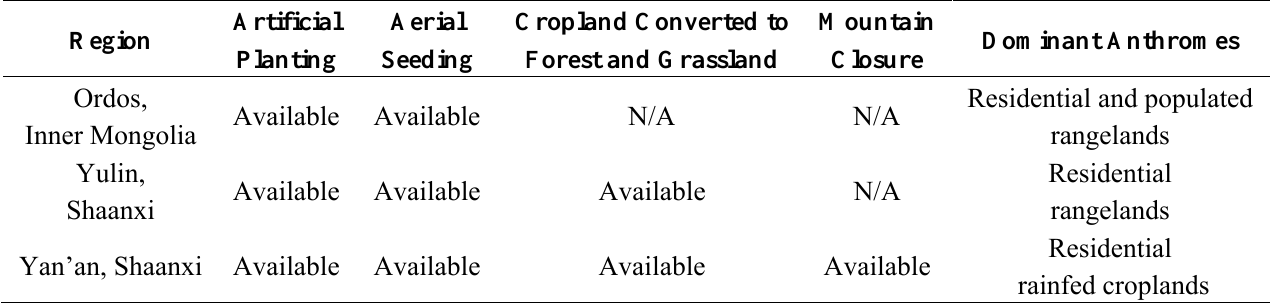
Table 2. Vegetation conservation activities in Ordos, Yulin, and